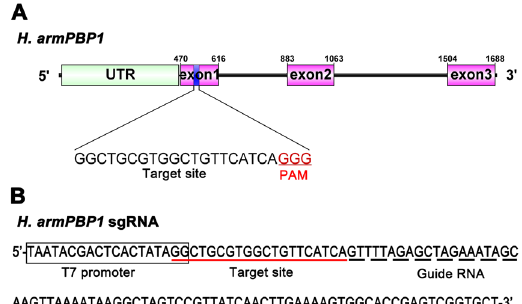
Figure 5. The sgRNA targeting site at HarmPBP1 ( A ) and template sequence of the sgRNA ( B ) of CRISPR/ Cas9 system. ( A ) The sgRNA targeting site is located at the exon 1, containing a protospacer and a protospacer adjacent motif (PAM) sequence (GGG, under-lined). ( B ) T7 promoter is followed by the DNA template of the